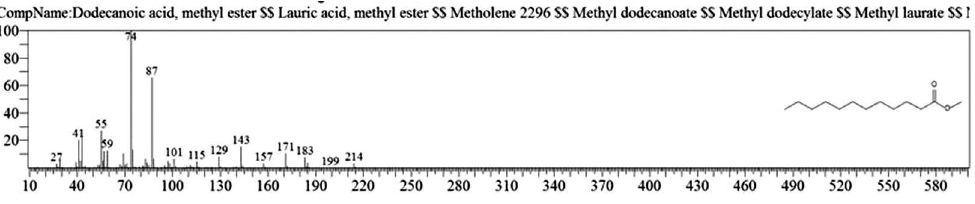
Fig. 6. Decanoic acid methyl ester